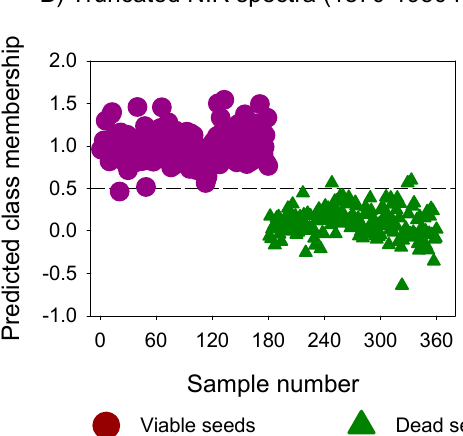
Figure 4. ( A ) The predicted class membership of viable and dead-filled seeds in the validation sets by discriminant models fitted on single seed NIR spectra of Mason’s pine (a), loblolly pine (b), slash pine (c) and all species combined (d) as well as truncated spectra of all species ( B ). The horizontal black dashed line is the classification threshold (Ypred > 0.5).